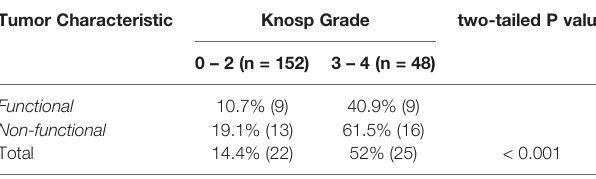
TABLE 2 | Percentage and distribution of residual adenoma fi nding in fi rst intraoperative magnetic resonance imaging according to tumor characteristic and Knosp Grade.